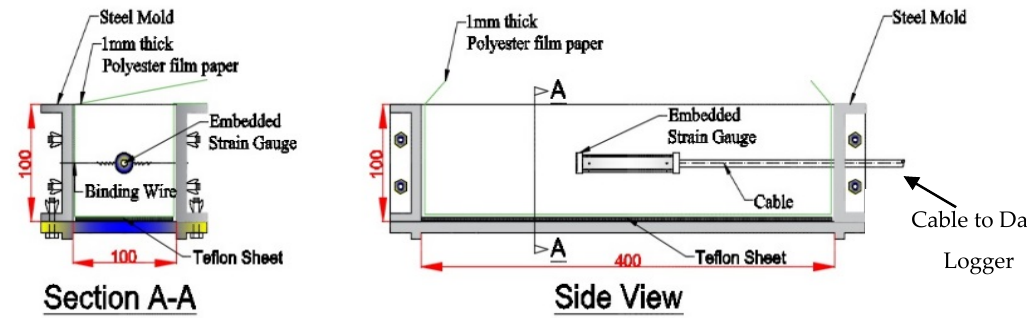
Figure 1. Beam concrete mold for shrinkage measurement.